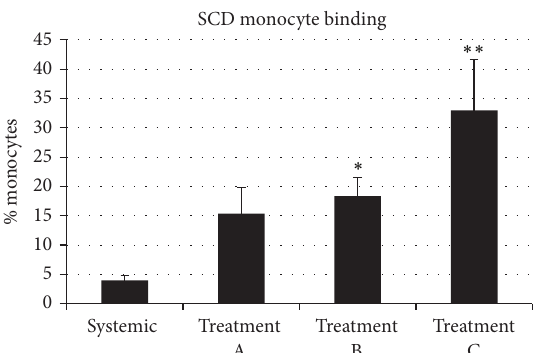
Figure 8: The differential percent of monocytes associated with the SCD membrane increased with each subsequent SCD treatment A, B, and C to 15 ± 4.5 , 18 ± 3.2 , and 33 ± 8.7 %, respectively. For treatments B and C, values are significantly higher than that of the systemic circulation value, prior to SCD treatment, of 4.0 ± 0.9 % ( 𝑝 = 0.012 ( ∗ ) and 0.03 ( ∗∗ ) for B and C versus systemic, resp., 𝑛 = 3